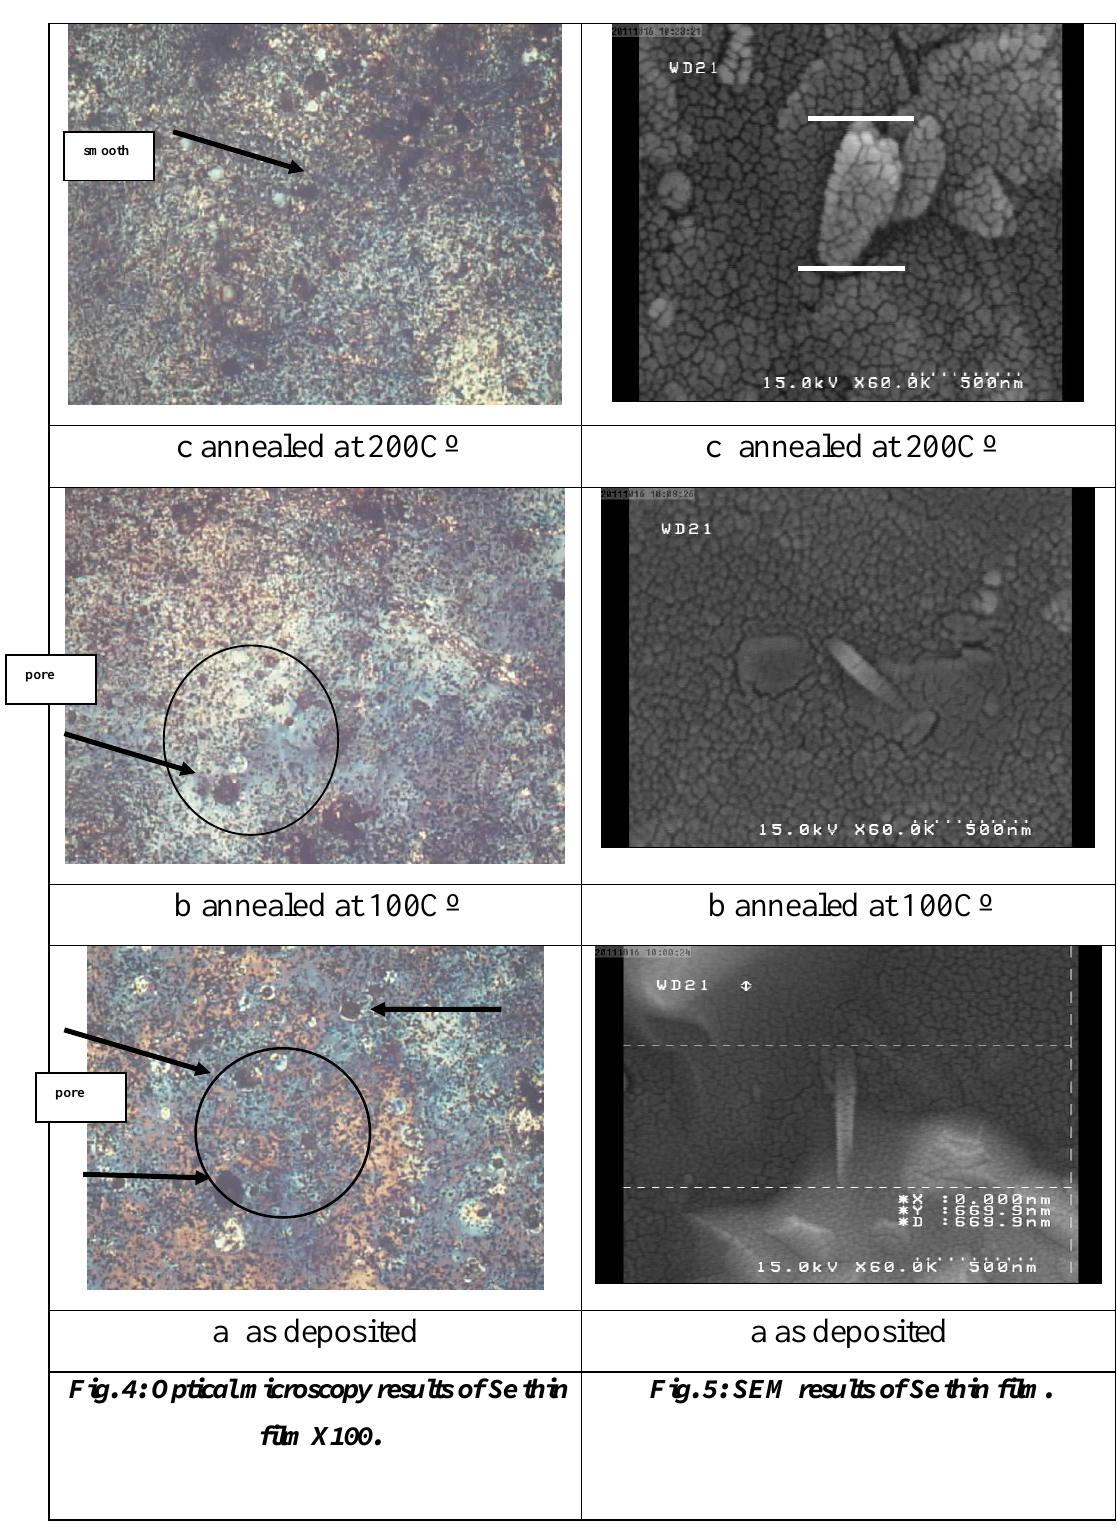
Fig. 4: Optical microscopy results of Se thin film X100.